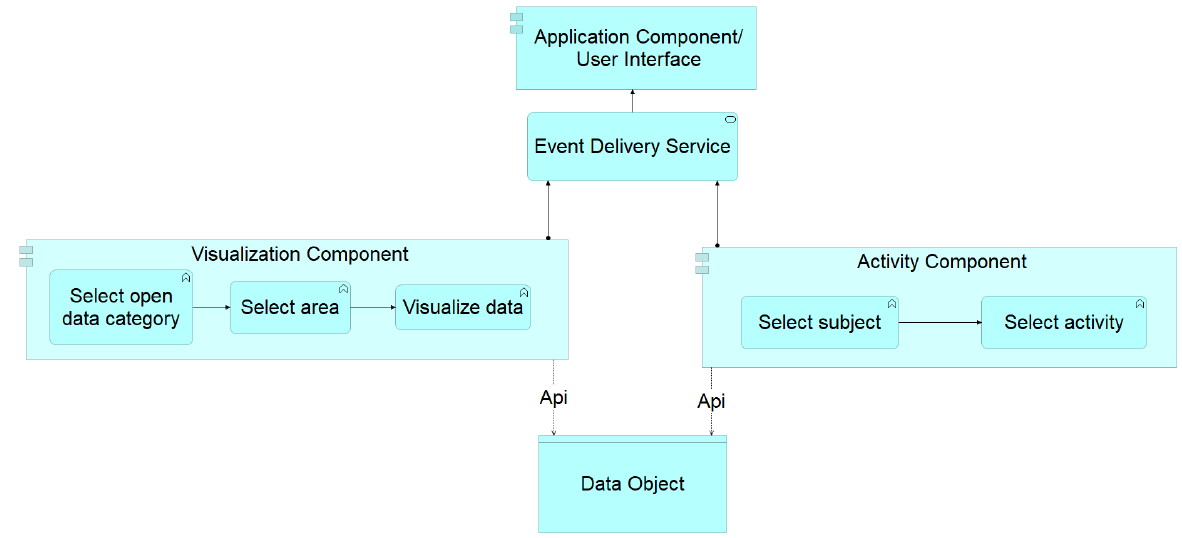
Figure 7. Application layer requirements